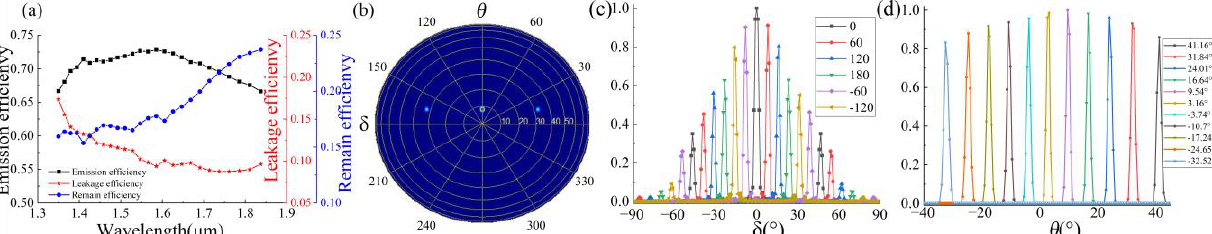
Figure 4. Scanning characteristics of OPA composed of the designed antenna based on 1 dB working wavelength range. ( a ) The 1 dB bandwidth of the antenna; ( b ) Far-field radiation simulation result of 16-optical antenna array; ( c ) Far-field radiation simulation result by considering each channel keeps ideal phase difference controlled by phase shifters; ( d ) Normalized optical output profile in the far-field as the beam was swept in the θ axis by changing the working wavelength from 1350 to 1850 nm.